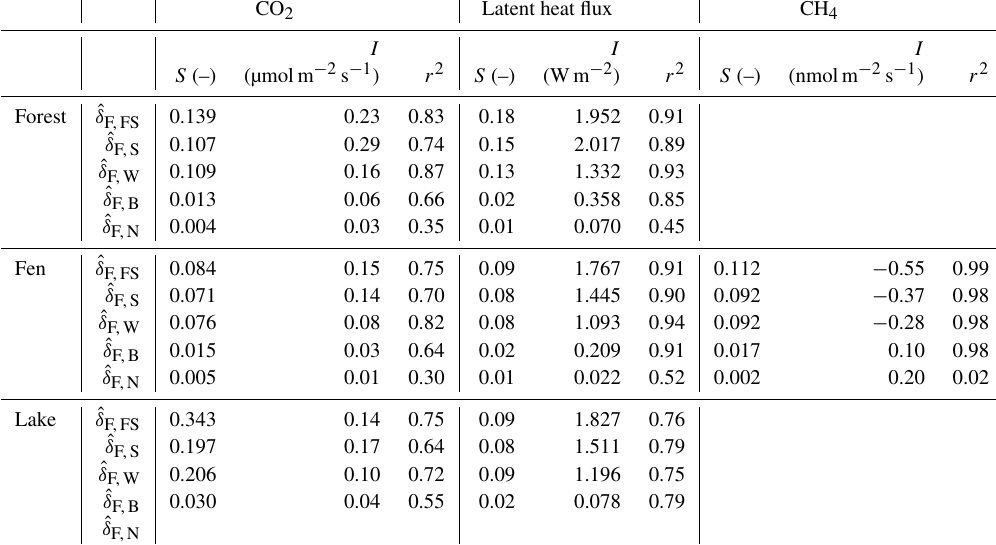
Table 2. Linear fitting parameters between absolute value of the flux and flux uncertainty estimates (uncertainty = | flux | × S + I ) obtained from measurements at three sites. Robust fitting method was used to minimise the effect of outliers.